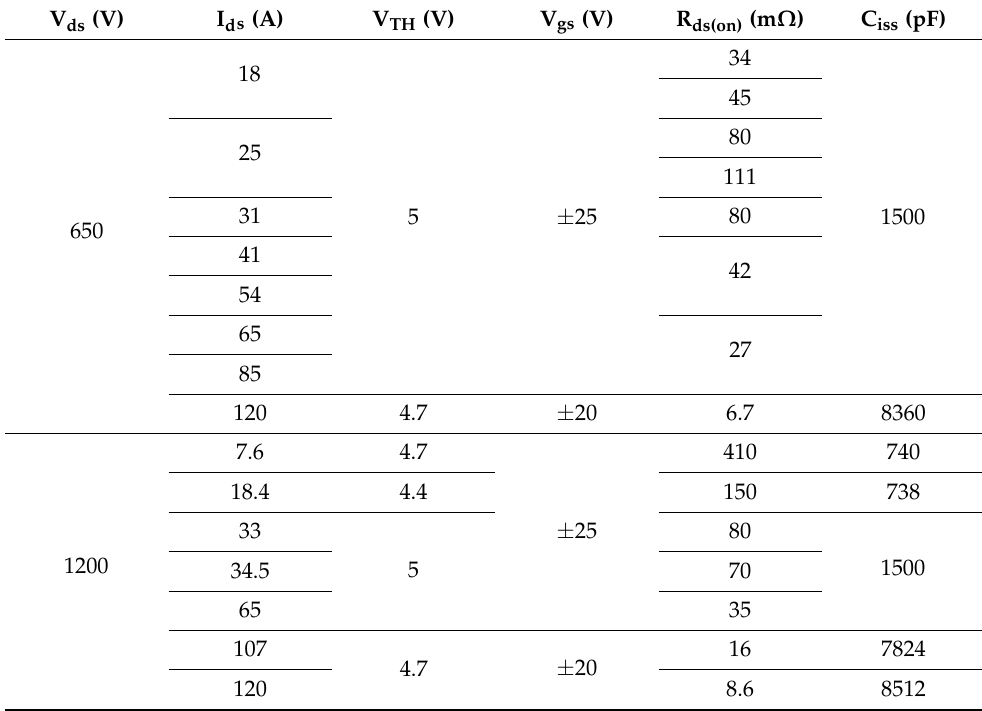
Table 10. Commercial 600~1200 V SiC MOSFETs by United Silicon